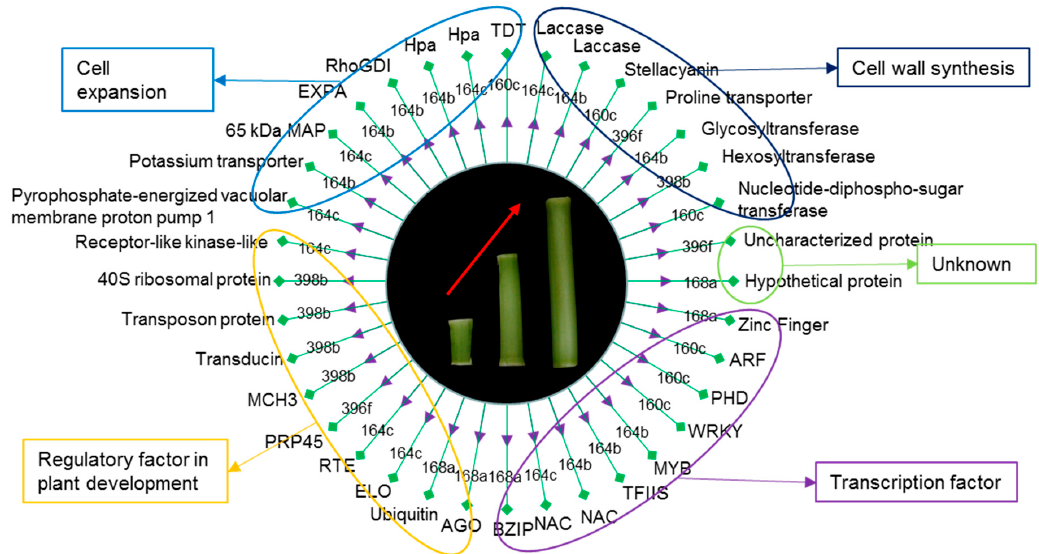
Figure 7. A proposed miRNA-regulatory network during internode elongation of